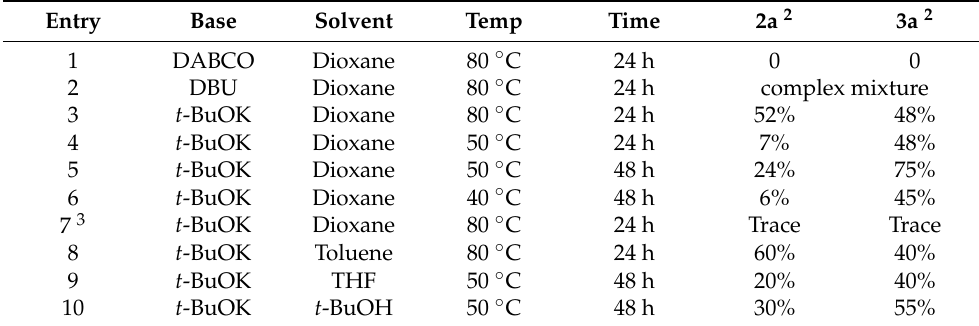
Table 1. Optimization for reaction of 1a with ethyl acetoacetate leading to 2a and 3a 1